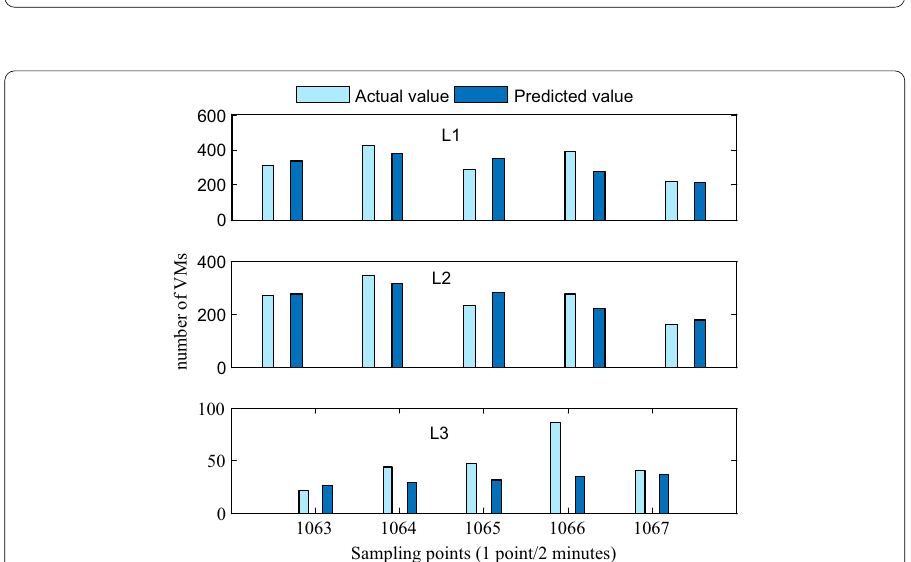
Fig. 9 Number of the predicted VMs for the L1, L2 and L3 sequences. The first, second and third subgraphs depict the comparison between the actual values and the predicted 5-point values obtained by our proposed method APMRT for the preprocessed L1, L2 and L3 sequences,